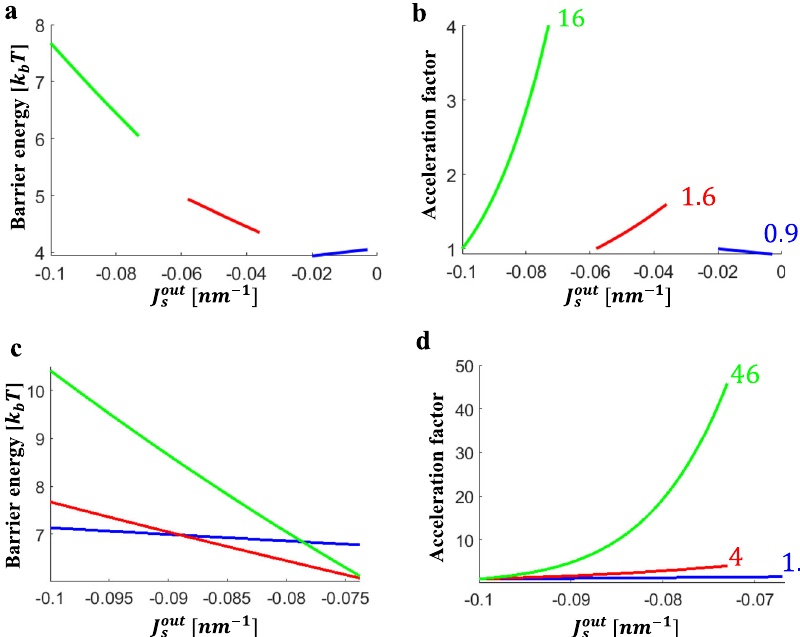
Fig. 3 Dependence of the energy barrier and the acceleration factor of the fusion pore formation on the spontaneous curvature of the proximal on the energy barrier ( a ) and the monolayers and on the tilt decay length. a , b describe the effects of varying background spontaneous curvature, J 0 S ¼ (cid:2) 0 : 02nm (cid:2) 1 , red line J 0 ¼ (cid:2) 0 : 058nm (cid:2) 1 , and green line J 0 ¼ (cid:2) 0 : 1nm (cid:2) 1 . c , d describe the effect of tilt decay length, acceleration factor ( b ): Blue line J 0 S S S l on the energy barrier ( c ) and the acceleration factor ( d ): Blue line l ¼ 1nm, red line l ¼ 1 : 5nm, and green line l ¼ 2nm. The parameter values used in all panels: x (cid:3) ¼ 6 : 6nm, R B ¼ 15nm, κ m ¼ 10 k b T, (cid:1) κ m ¼ (cid:2) 5 k b T , and λ ¼ 10pN. The tilt decay length size used in a and in b is l ¼ 1 : 5nm and the background ¼ (cid:2) 0 : 1nm (cid:2) 1 . In panels b and d the acceleration factor is indicated for the maximal calculated area fraction of spontaneous curvature in panels c and d is J 0 S ¼ (cid:2) 0 : 02nm (cid:2) 1 , maximal fraction of LPC is 6%, β ¼ 0 : 9. Red line, J 0 ¼ (cid:2) 0 : 06nm (cid:2) 1 ; maximal fraction of LPC in the proximal monolayers. b : Blue line, J 0 S S ¼ (cid:2) 0 : 1nm (cid:2) 1 ; maximal fraction of LPC is 7.5% LPC, β ¼ 4. d : Blue line, l ¼ 1nm ; maximal fraction of LPC is 10%, β = 1.5 LPC is 6.8%, β ¼ 1 : 6. Green line, J 0 S Red line, l ¼ 1 : 5nm ; maximal fraction of LPC is 7.5%, β = 4. Green line, l = 2 nm, maximal fraction of LPC is 7.5%, β =